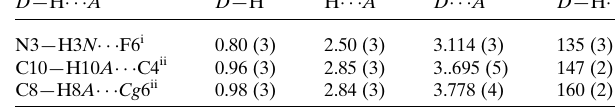
Table 4 Hydrogen-bond geometry (A˚ , (cid:3) ) for 2 . Cg 6 is the centroid of the C1–C6 ring.